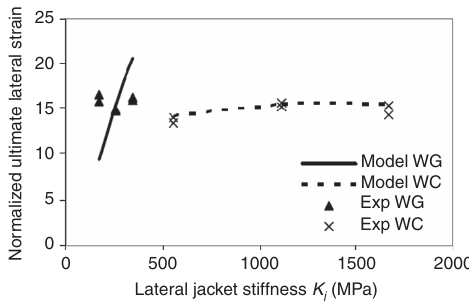
Figure 12 Normalized ultimate axial strain versus the modified effective confinement index α ′ ω